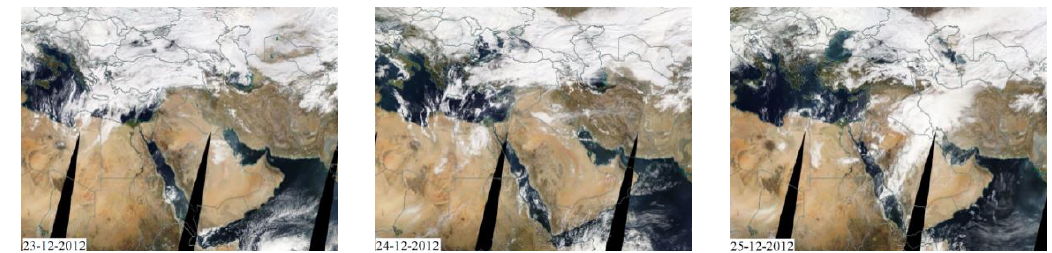
Figure 5: The satellite images illustrate the cloud over Iraq during the period (23-25 December 2012)